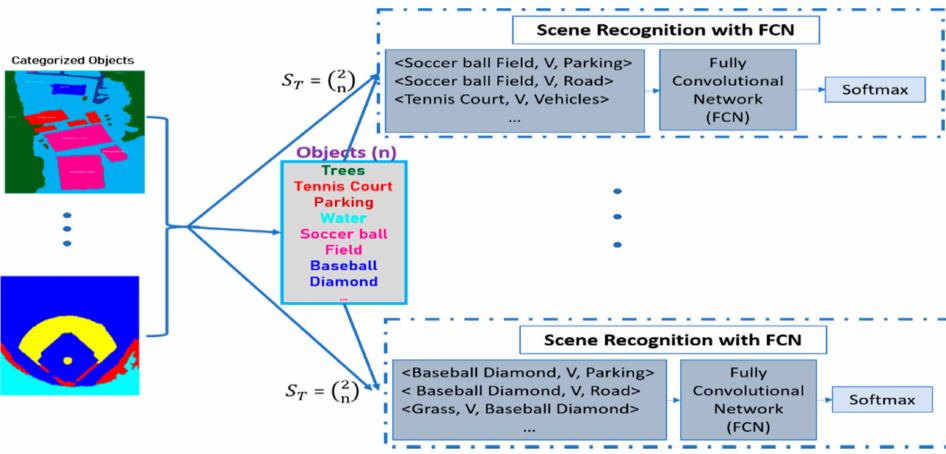
Figure 8. Schematic view of OORs between object triplets present in the remote sensing